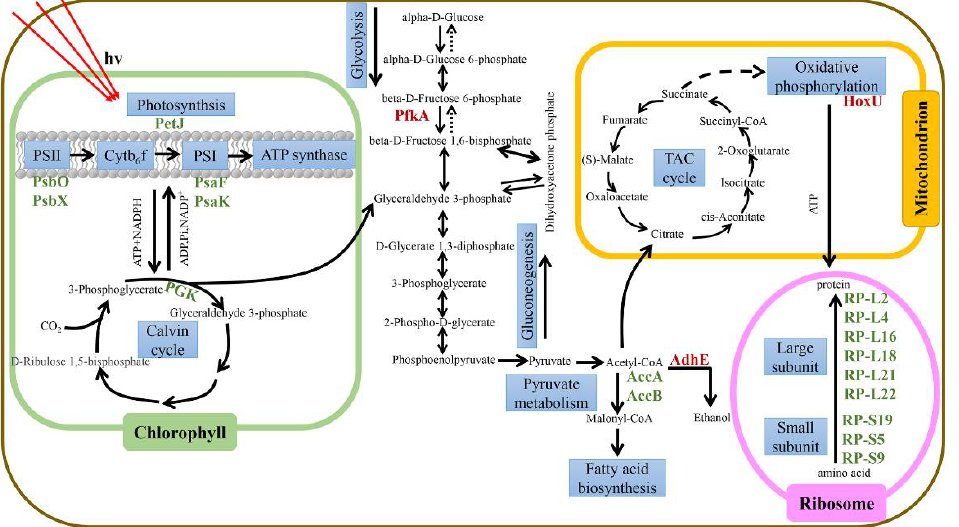
Figure 5. Schematic diagram of cellular metabolic pathways derived from transcriptome analysis of Microcystis aeruginosa under iron limitation. The arrows represent biochemical pathways. Black font indicates metabolites. The red and green bold names indicate gene expression that is up- or down-regulated in response to iron limitation.